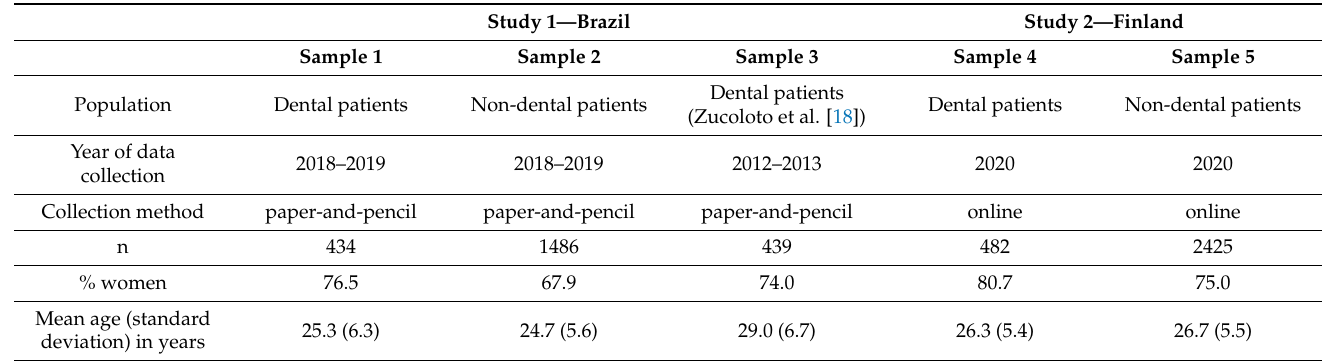
Table 1. Description of study